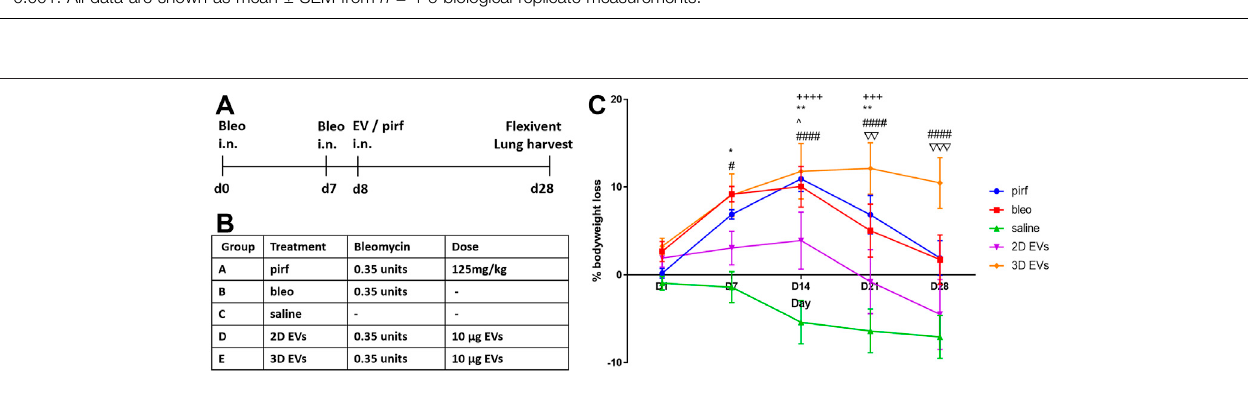
Frontiers in Cell and Developmental Biology |